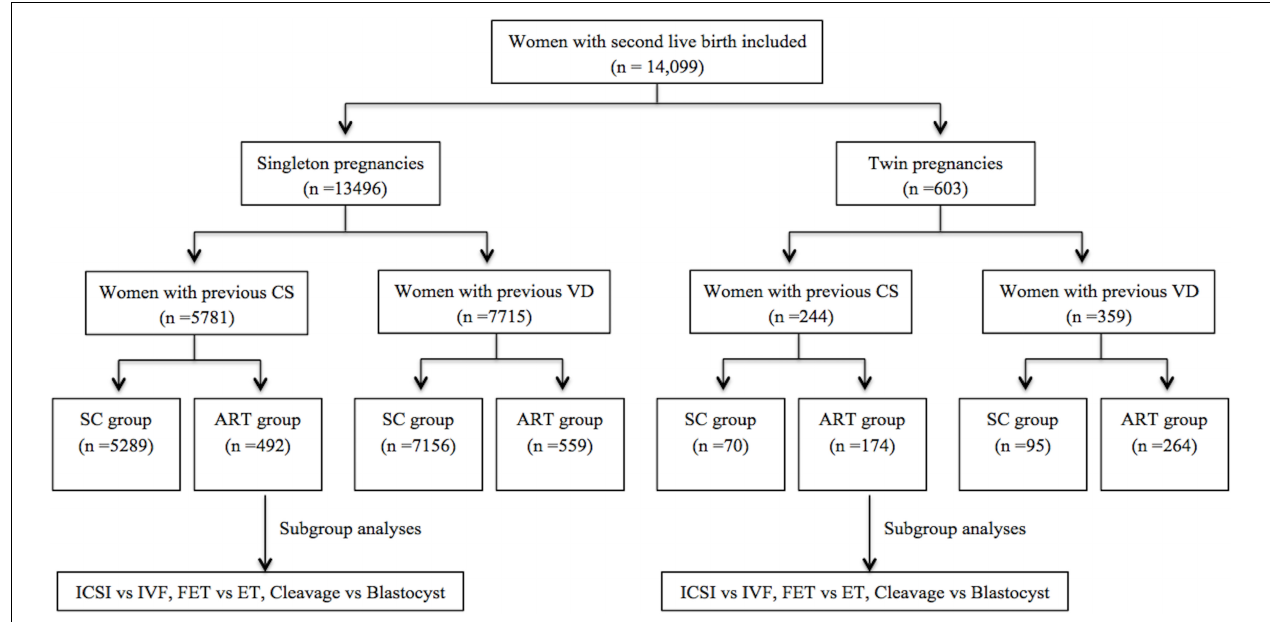
FIGURE 1 | Flow chart of the population in a study of obstetric and perinatal outcomes in women with a single previous full-term delivery. ART, assisted reproductive technology; SC, spontaneously conceived; CS, Cesarean section; VD, vaginal delivery; IVF, in vitro fertilization; ICSI, intracytoplasmic sperm injection; ET, embryo transfer; FET, frozen-thawed